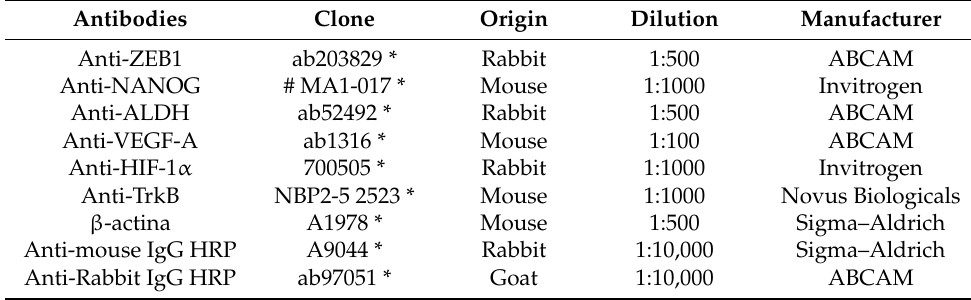
Table 3. Antibodies used for Western blotting